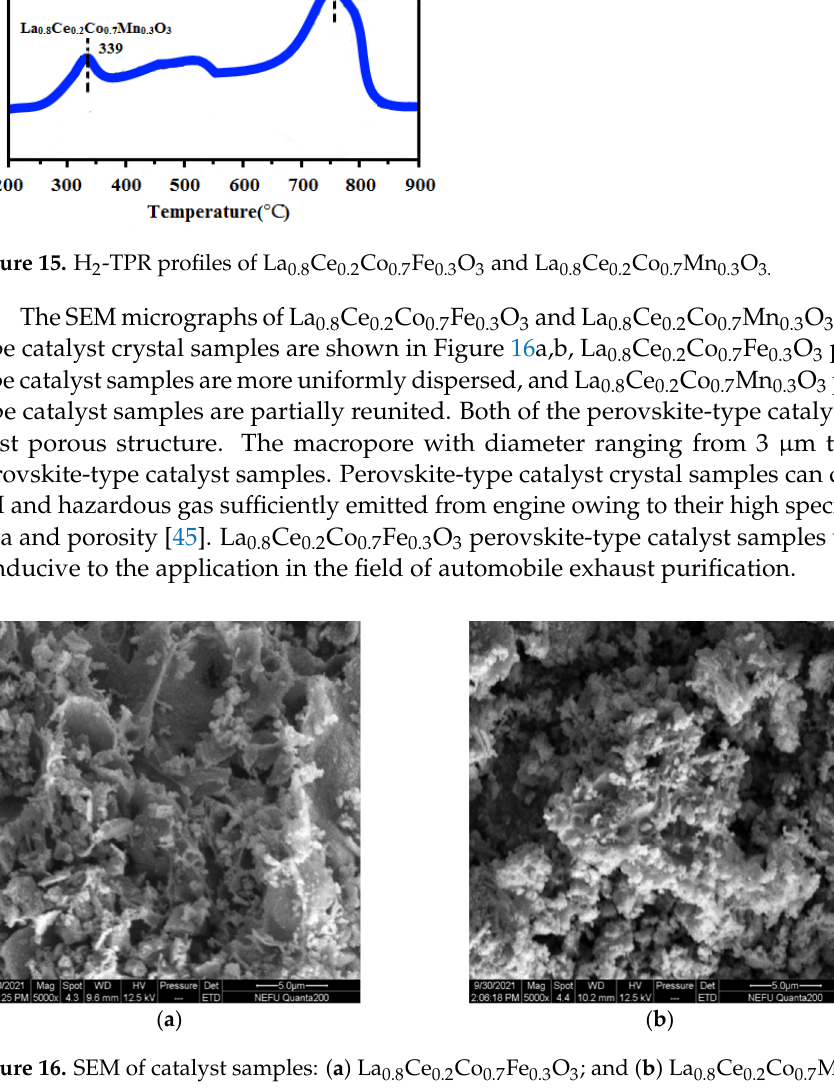
Figure 16. SEM of catalyst samples: ( a ) La 0.8 Ce 0.2 Co 0.7 Fe 0.3 O 3 ; and ( b ) La 0.8 Ce 0.2 Co 0.7 Mn 0.3 O 3 .